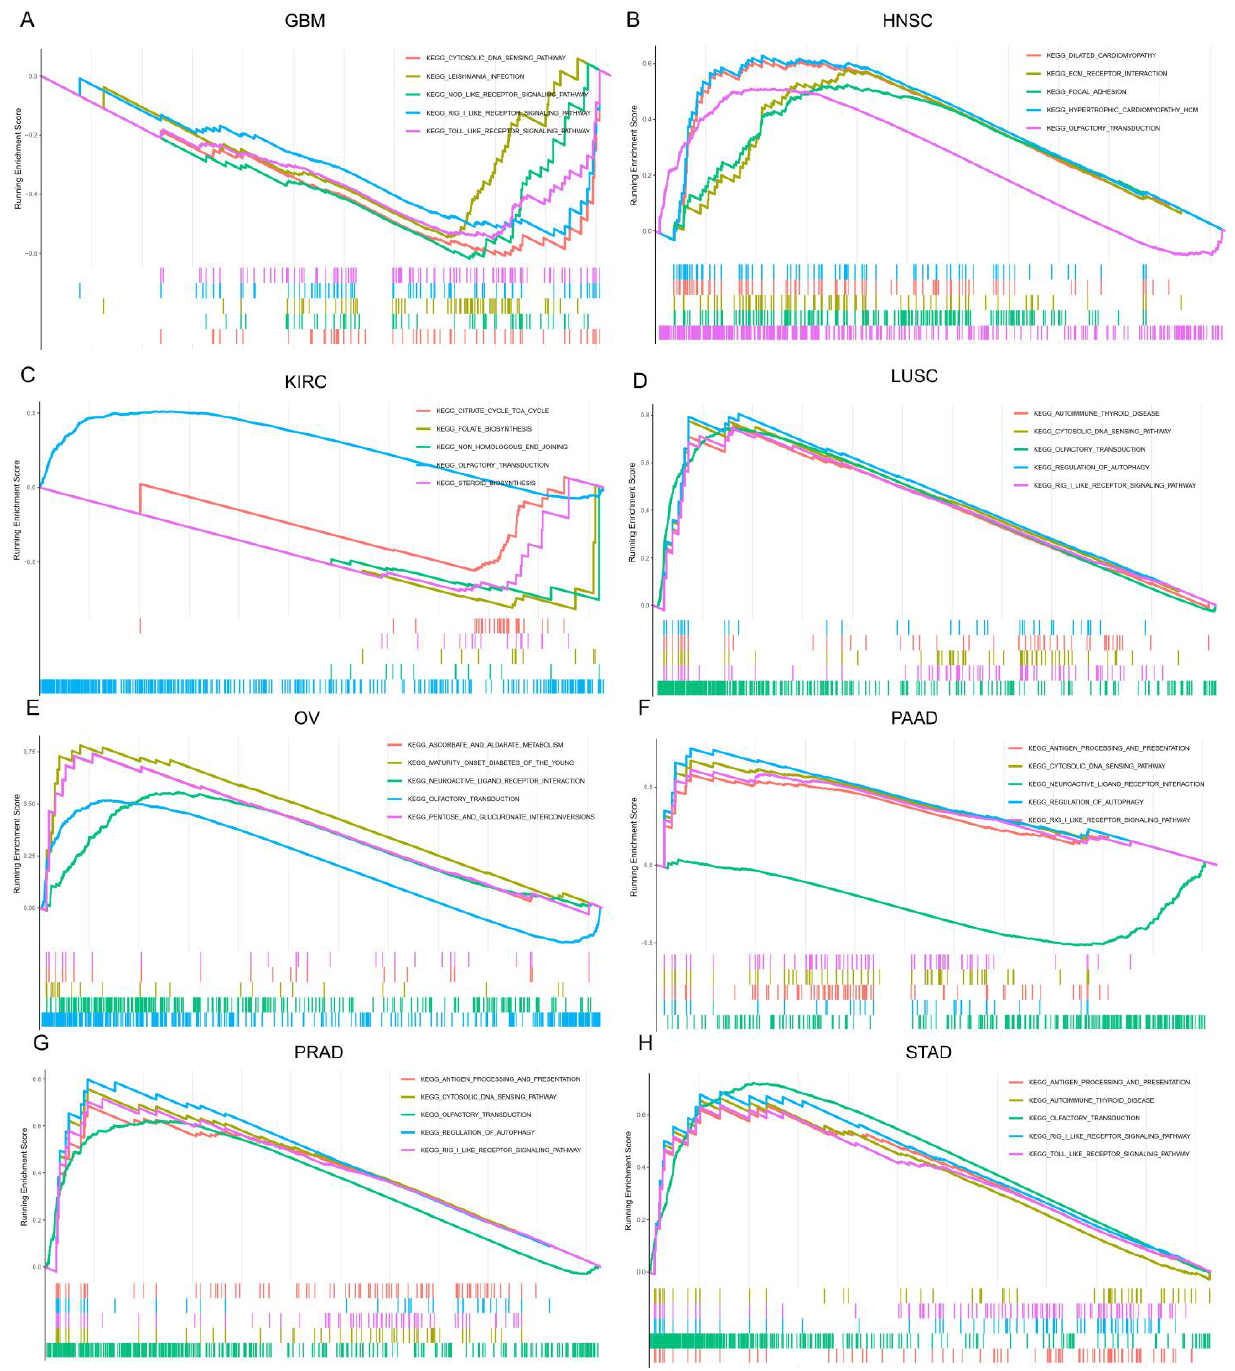
Figure 10. The Gene Set Enrichment Analysis (GSEA) in Kyoto Encyclopedia of Genes and Genomes (KEGG) signature of GBM, HNSC, KIRC, LUSC, OV, PAAD, PRAD and STAD. The curves with different colors indicate the different pathway annotations. Peaks in the upward direction indicate positive regulation by SOX11 and peaks in the downward direction represent negative regulation by SOX11 . ( A ) The GSEA analysis of SOX11 -mediated biological process in GBM; ( B ) The GSEA analysis of SOX11 -mediated biological process in HNSC; ( C ) The GSEA analysis of SOX11 -mediated biological process in KIRC; ( D ) The GSEA analysis of SOX11 -mediated biological process in LUSC; ( E ) The GSEA analysis of SOX11 -mediated biological process in OV; ( F ) The GSEA analysis of SOX11 - mediated biological process in PAAD; ( G ) The GSEA analysis of SOX11 -mediated biological process in PRAD; ( H ) The GSEA analysis of SOX11 -mediated biological process in